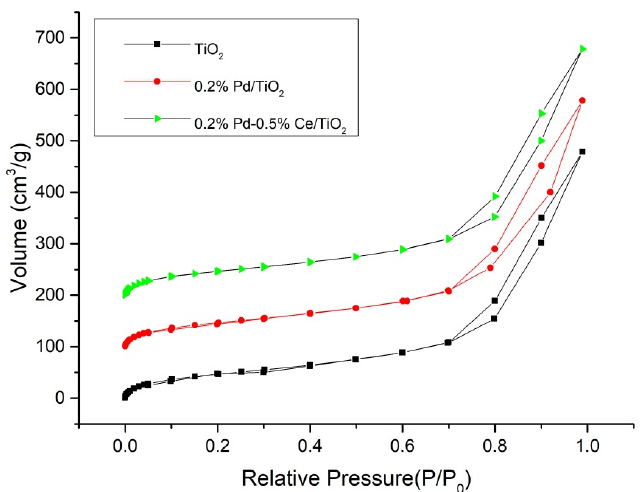
Figure 1. N 2 adsorption-desorption isotherms of TiO 2 , 0.2% Pd/TiO 2 , and 0.2% Pd-0.5% Ce/TiO 2.